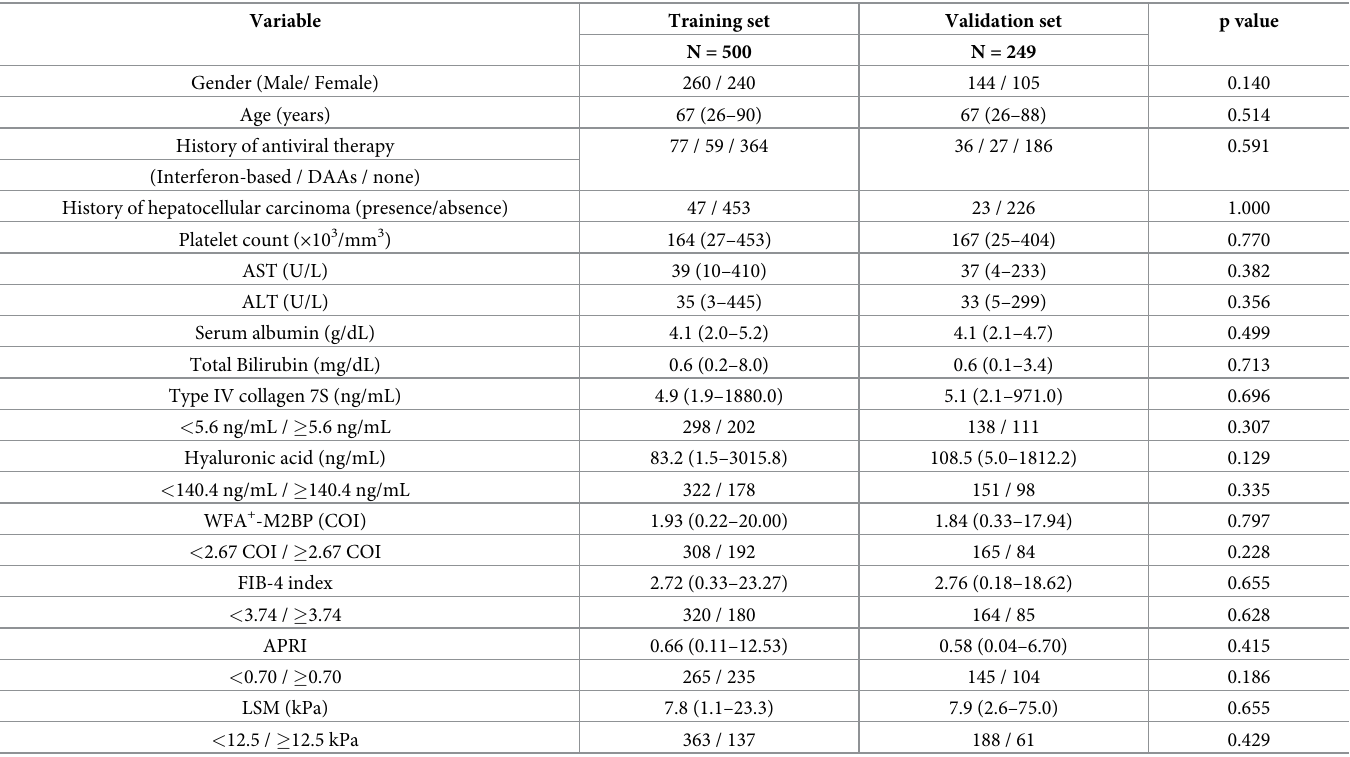
Table 1. Baseline characteristics of the